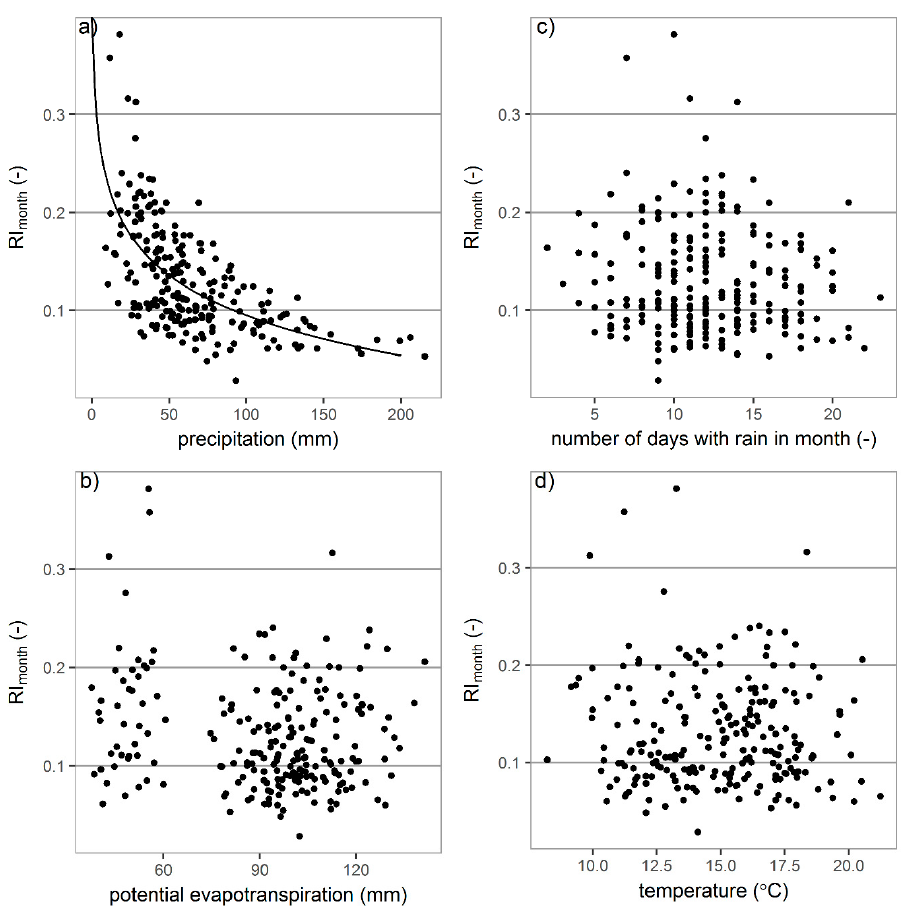
Figure 9. Relationship between relative month interception (RI month ) and: ( a ) sum of precipitation; ( b ) sum of potential evapotranspiration; ( c ) number of days with rain; ( d ) mean temperature. Table 4. Statistically significant ( p -value < 0.05) correlation coefficients for relation between growing season absolute interception (AI), relative interception (RI) and meteorological elements.